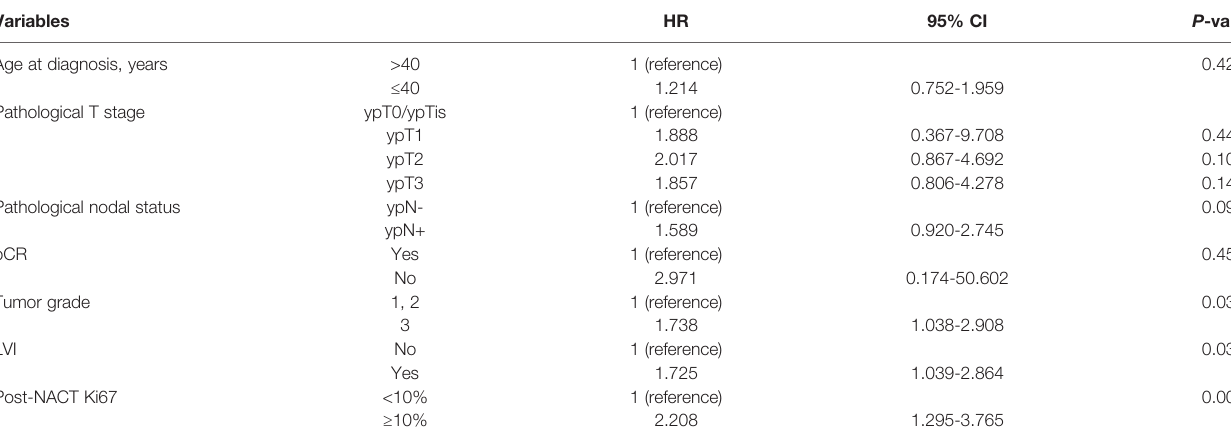
TABLE 4 | Multivariate analysis of risk factors associated with LRR.